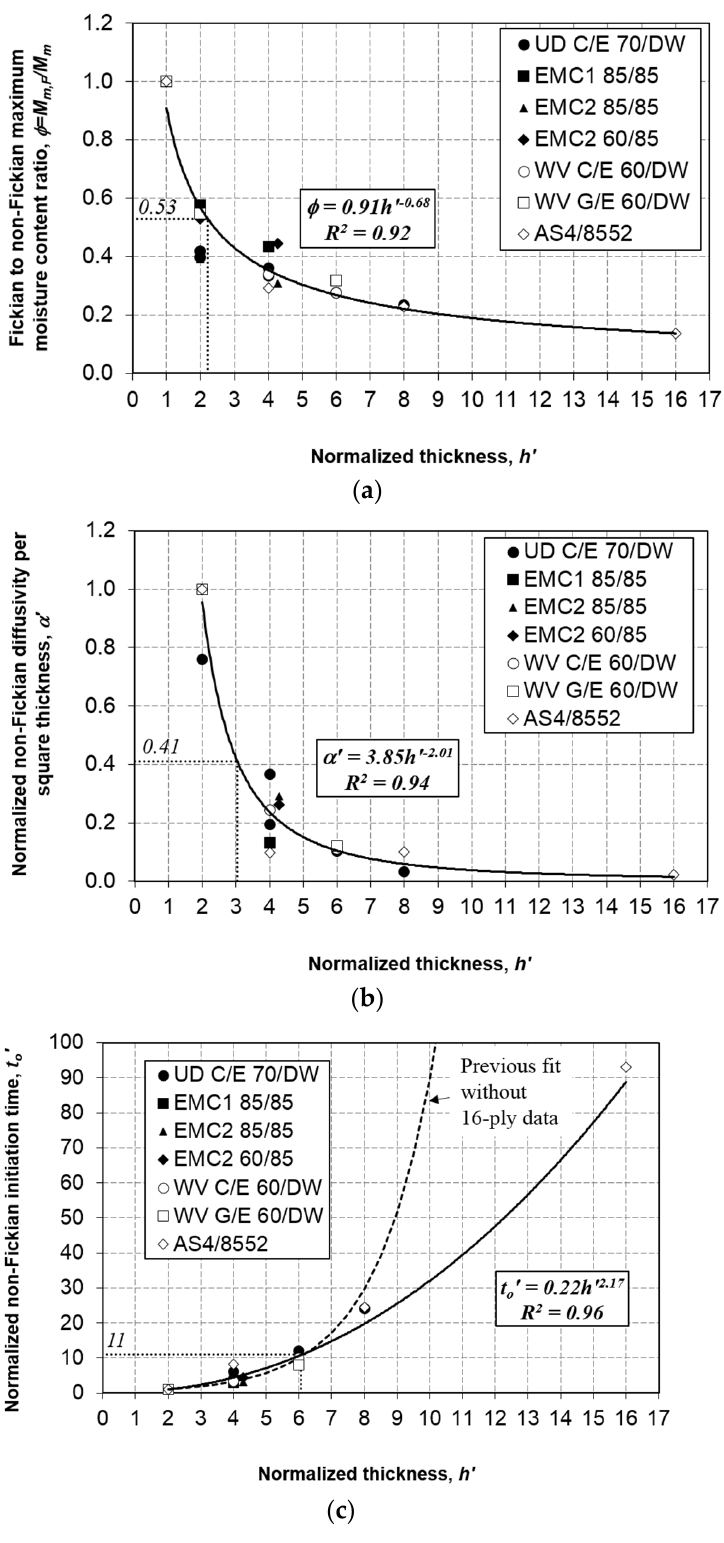
Figure 8. Variation of the non-Fickian parameters with the normalized thickness: ( a ) Fickian to non-Fickian maximum moisture content ratio ϕ ; ( b ) normalized non-Fickian diffusivity per square thickness α ’ ; and ( c ) normalized non-Fickian initiation time t o ’.